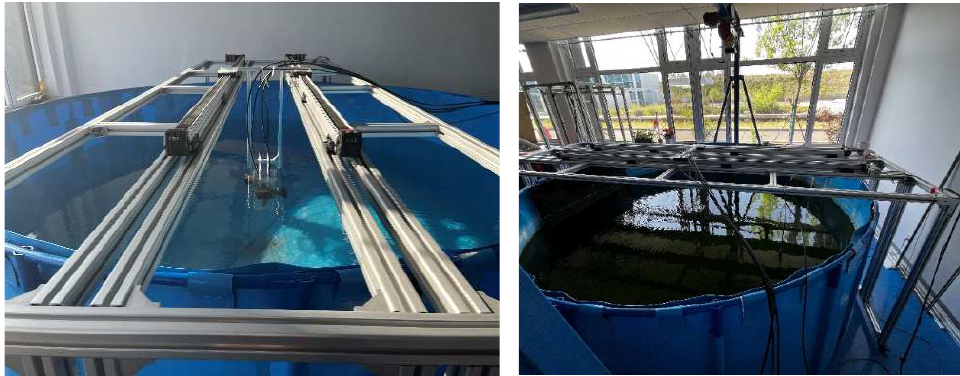
Figure 8. Comparison of 10 kHz ultrasonic transducer’s measurements with two types of ultrasonic- transducer calibration devices.